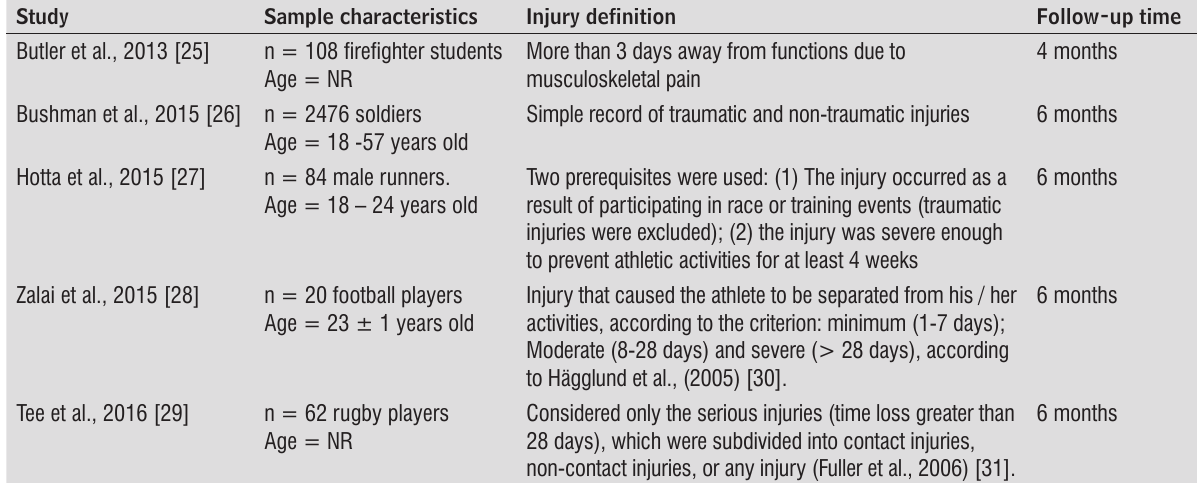
Table 1 - Characteristics of the studies included.